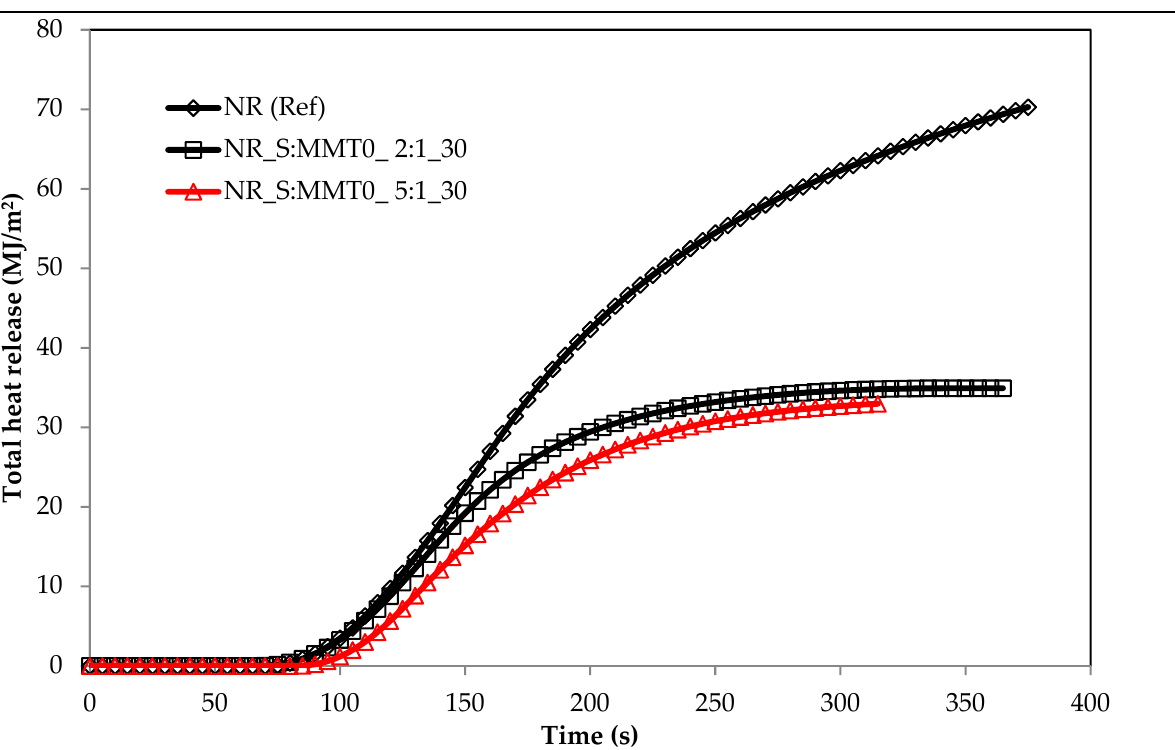
Figure 17. The HRRmax parameter of biocomposites filled with S:MMT0.